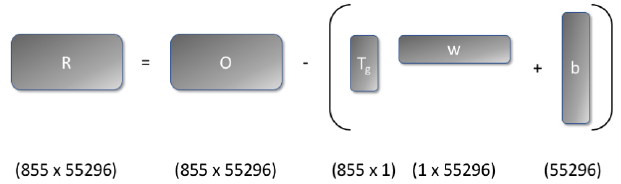
Figure 1. Schematic of the residual calculation showing the shapes of the matrices involved. The result of the outer product T g w (cid:62) is an 855 × 55296 matrix. The vector b is added to this matrix using the broadcast convention described in Sect.